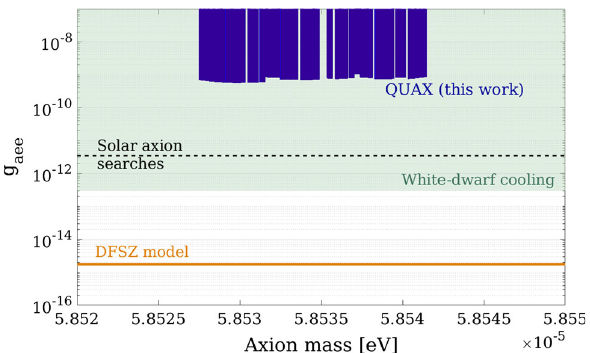
Fig. 8 Excluded values of the g aee coupling (blue area) compared to its theoretical prediction for the DFSZ axion model with β = 1 (orange line) and a DM density of 0.45GeV/cm 3 . The green shaded area is excluded by white dwarf cooling [65–67], while the black dashed line is the best upper limit obtained with solar axion searches relying on the axio-electric effect [68–74]. Other statistically significant limits can be found in